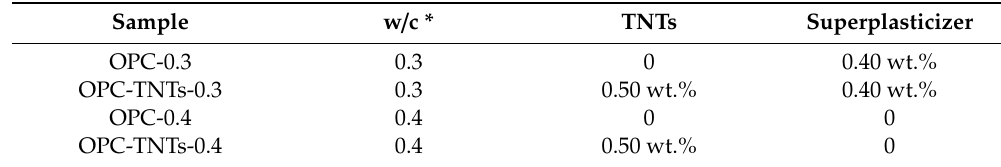
Table 2. Mixing proportions of TNTs / OPC.